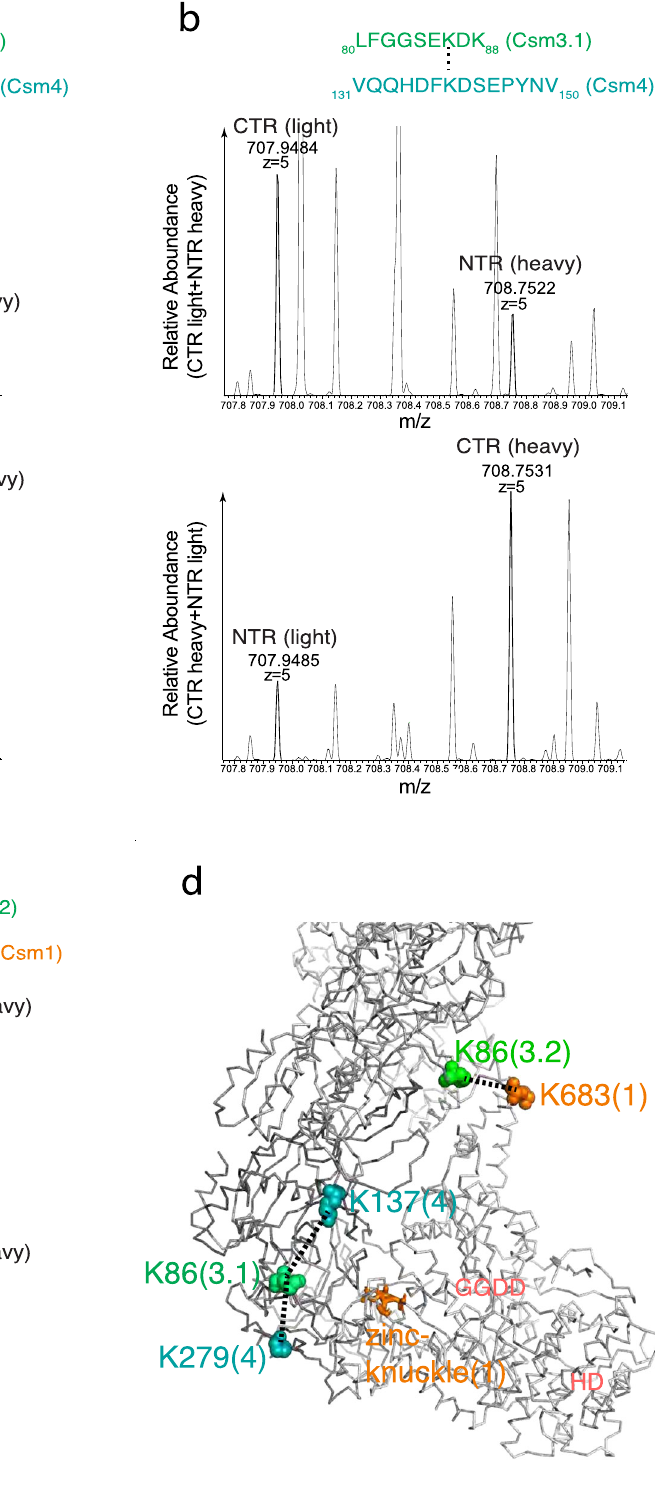
specimen level and − 1.3 to − 2.8 microns defocus. A 60.07 e − /Å 2 – 61.51 e − /Å 2 dose was applied over 70 – 74 frames at a total exposure time of 3.09 – 4.5s. A total of 5179 images were collected from the CTR-bound complex in a movie mode (Figure S3). Images showing bad ice, astigmatism, drift, and poor sample quality were rejected resulting in 2543 images for further processing and particle picking, which resulted in a total of 2,157,655 particles. Several rounds of 2D classi fi cation led to 613,110 particles with good quality. RELION-3 49 was used